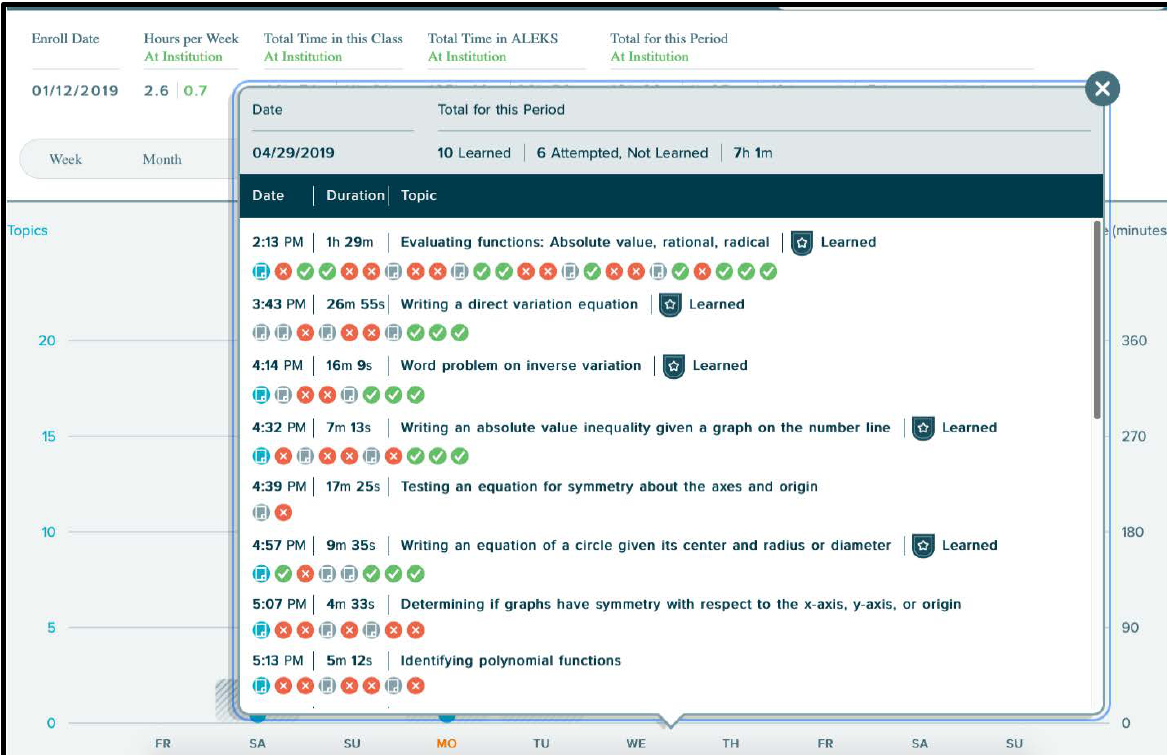
Figure 8b. Time and Topic (ALEKS) show the actions of the student in the learning path. This snapshot shows that on April 29 the student failed to learn three topics (attempted, but didn’t learn). The instructor can see that the student accessed the explanation page before the last attempt. The student’s answers are recorded and can be referred to when the instructor meets with the student for one-on-one tutoring. Adapted from MAC1105C: College Algebra , by R. Ait Maalem Lahcen, 2019, Orlando, FL: University